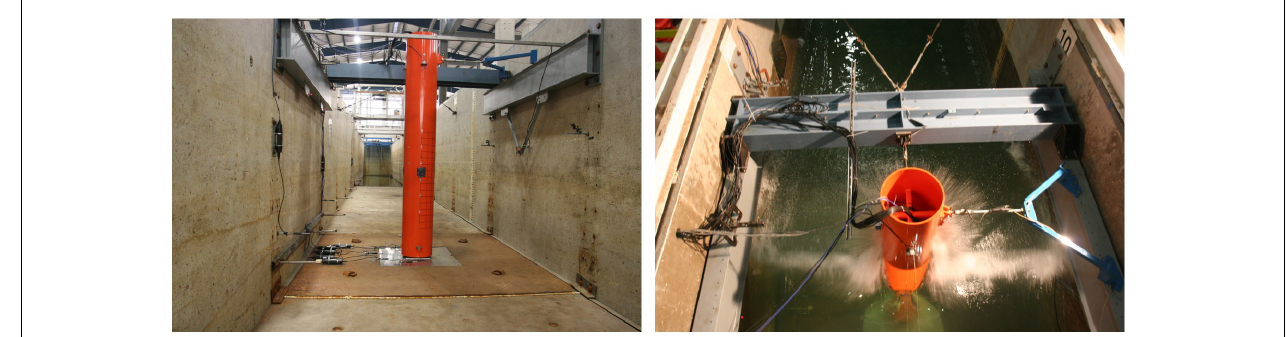
FIGURE 10 | Setup of specimen in LWF (left) and impulsive breaking wave tests (right) .